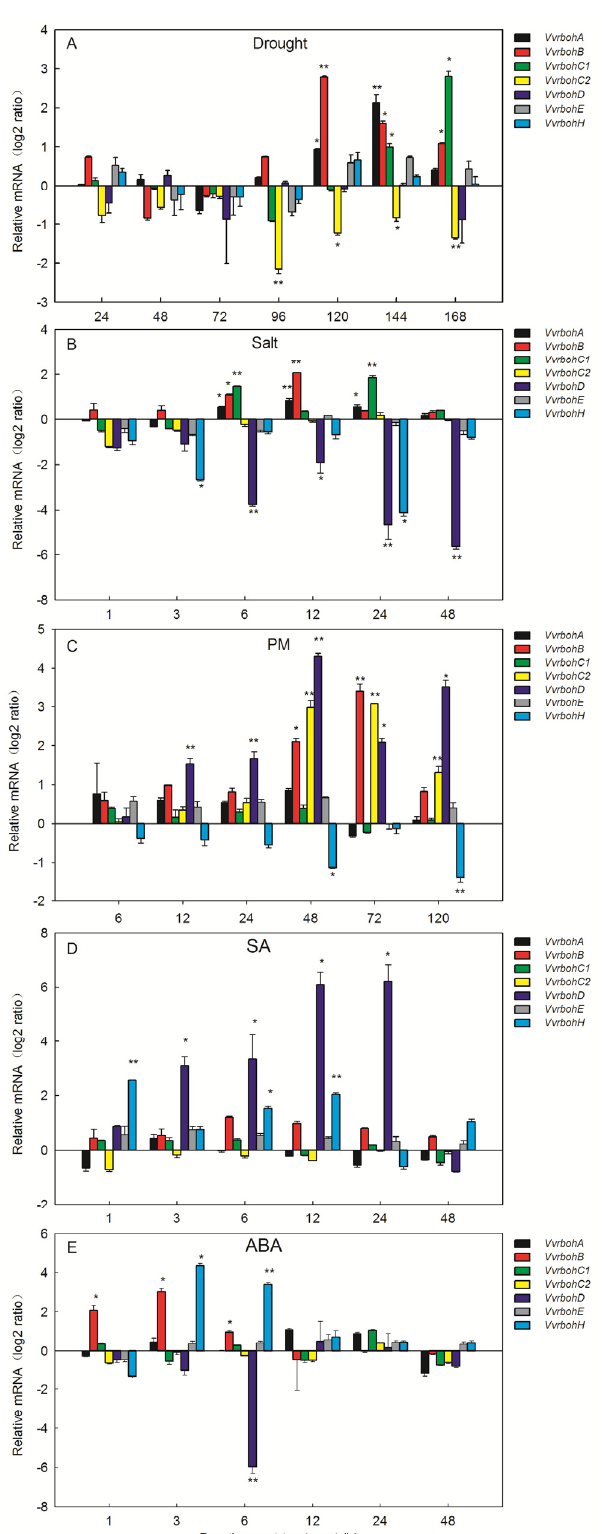
Figure 6. Effect of drought ( A ); salt ( B ); powdery mildew (PM) ( C ); salicylic acid (SA) ( D ) and abscisic acid ( E ) on the expression of Vvrboh gene expression in leaves was investigated by qRT-PCR. The grape actin1 gene was used as the reference gene. Error bars represent SE ( n = 3). Asterisks indicate levels of significance of differential expression ( t- test, * p ≤ 0.05, ** p ≤